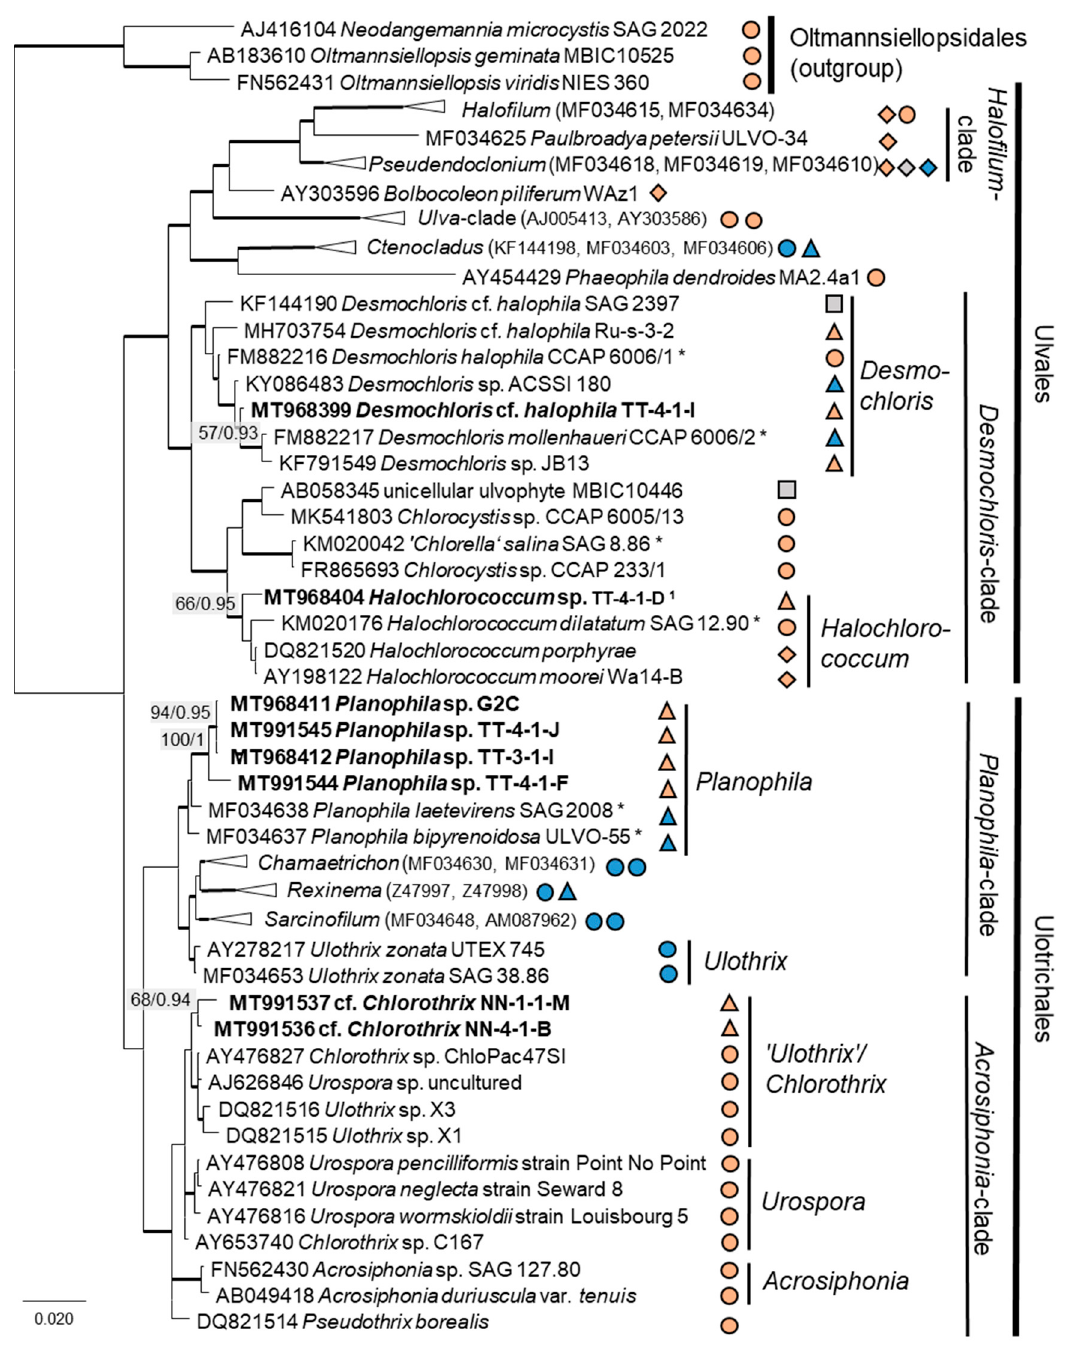
Figure 4. Molecular phylogeny of the Ulvophyceae based on SSU rRNA gene sequencing. The phylogenetic tree was calculated by the Bayesian method, including posterior probabilities (PP) with additional maximum likelihood bootstrap values (BP); branches are supported by both methods in bold (BP > 60% and PP > 0.9). Authentic strains were marked with an asterisk, original strains from this study in bold. Habitats of the strains were classified according to habitat type ( Δ terrestrial = absence of permanent water, o aquatic = presence of water, ◊ phycobiontic or endophytic, and □ unknown) and saline (